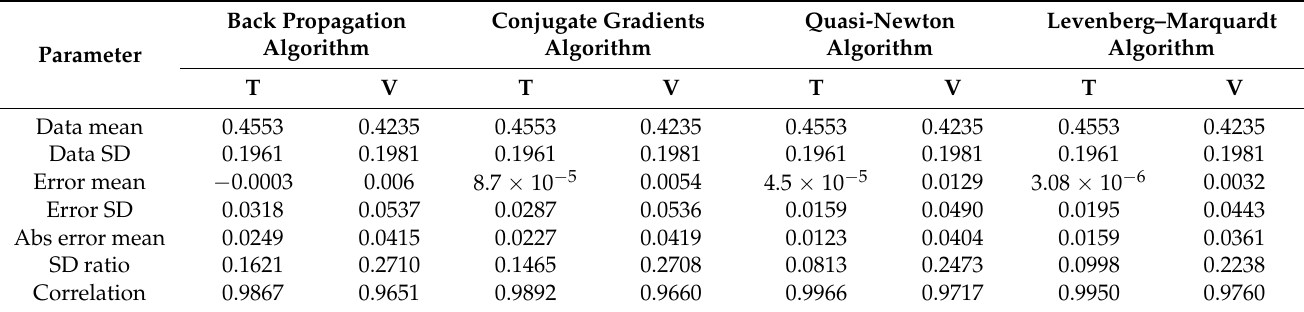
Table 4. Basic regression statistics for training (T) and validation (V)